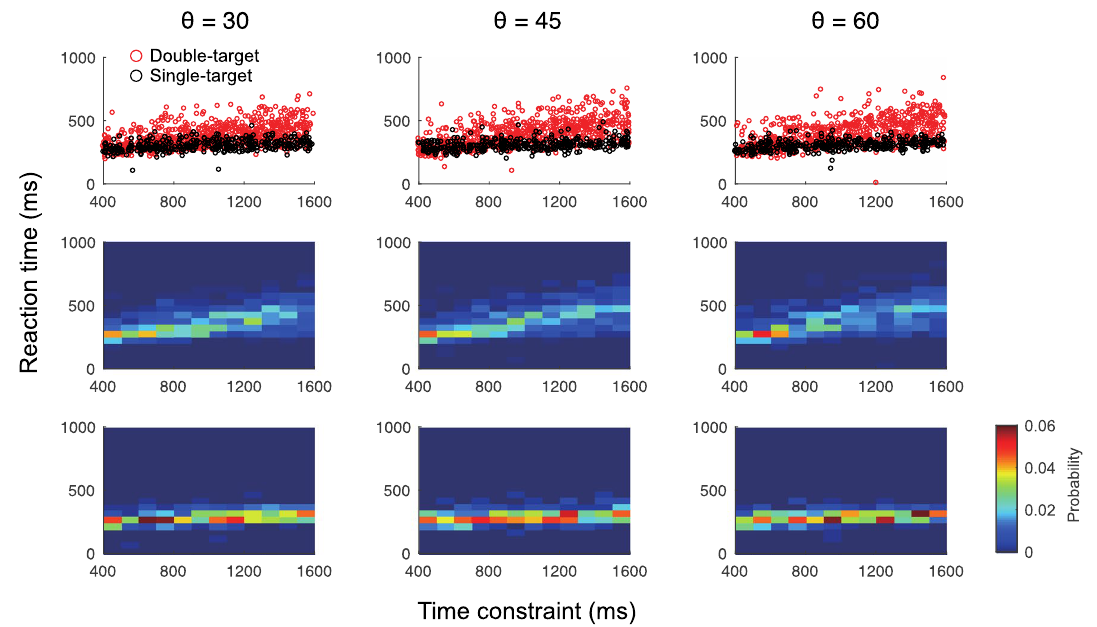
Figure 6. Comparison of reaction time according to time constraint between the double-target condition and the single-target condition. The upper panel shows a scatter plot of reaction times (of all participants) at a given time constraint. The middle and bottom rows show bivariate histograms (color maps) of time constraints and reaction times for the double-target and single-target conditions. These figures confirmed that the reaction times were comparable among the conditions when the time constraint was short, while the discrepancy in reaction times between the conditions increased as the time constraint became longer. Although the reaction times were similar between conditions under short time-constraints, the deviation of reaction times becomes larger as the time-constraint became